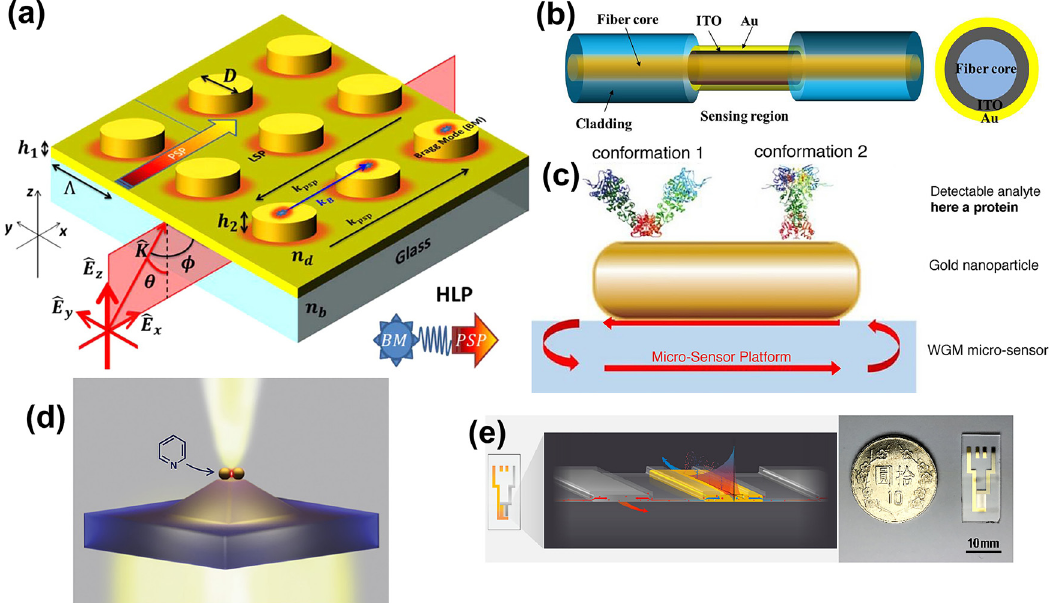
Figure 13: The diverse blueprints for plasmon-based sensing. (a)Sensingdevicewithawidetunabilityduetothestrongdispersionofhybridlatticeplasmonmodes.AdaptedfromthestudybySarkaretal. [279]. Copyright © 2015, American Chemical Society. (b) A compact plasmonic sensor for in situ analysis based on photon-plasmon coupling with fi bre-optics. Adapted from the study by Li et al. [280]. © The Optical Society. (c) Plasmonic nanoparticle coupled to whispering gallery mode (WGM) for single molecule detection. Adapted from the study by Frustaci and Vollmer [281] under Creative Commons Attribution 4.0 InternationalLicense.(d)Molecularweighingscalewithsinglemoleculesensitivitydownto4zg.AdaptedfromthestudybyProustetal.[282]. Copyright©2019,AmericanChemicalSociety.(e)Convenientlab-on-chipdesignforaplasmonicsensorbasedonhotelectrons.Adaptedwith permission from the study by Wang et al.